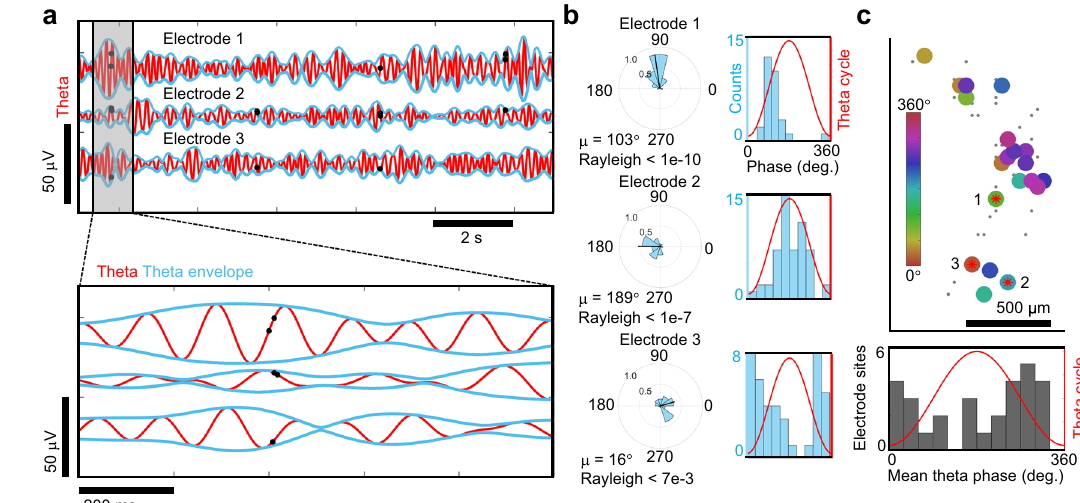
Fig.8|Phase-lockingofspikestothetaoscillations.a Top,thetaoscillations(red line) from three representative electrode sites and the single-unit spikes that occurredateachofthoseelectrodes(blackdots).Bottom,zoomedinviewfromthe gray box on the top. b Left, circular distribution of theta phase angles occurring during single-unit spike events measured from the electrodes in a . Directionof the mean spike angle ( µ ) relative to the theta phase and magnitude (mean resultant length)areshowninthepolarplots.TheRayleightestfornon-uniformitywasused to determine if spikes were distributed non-uniformly over the theta cycle (0°, 360°).Right,distributionsoftheta-spikeanglesshownrelativetothethetacycleare visualized as histogram plots. c Top, a cluster of phase-locked units to theta